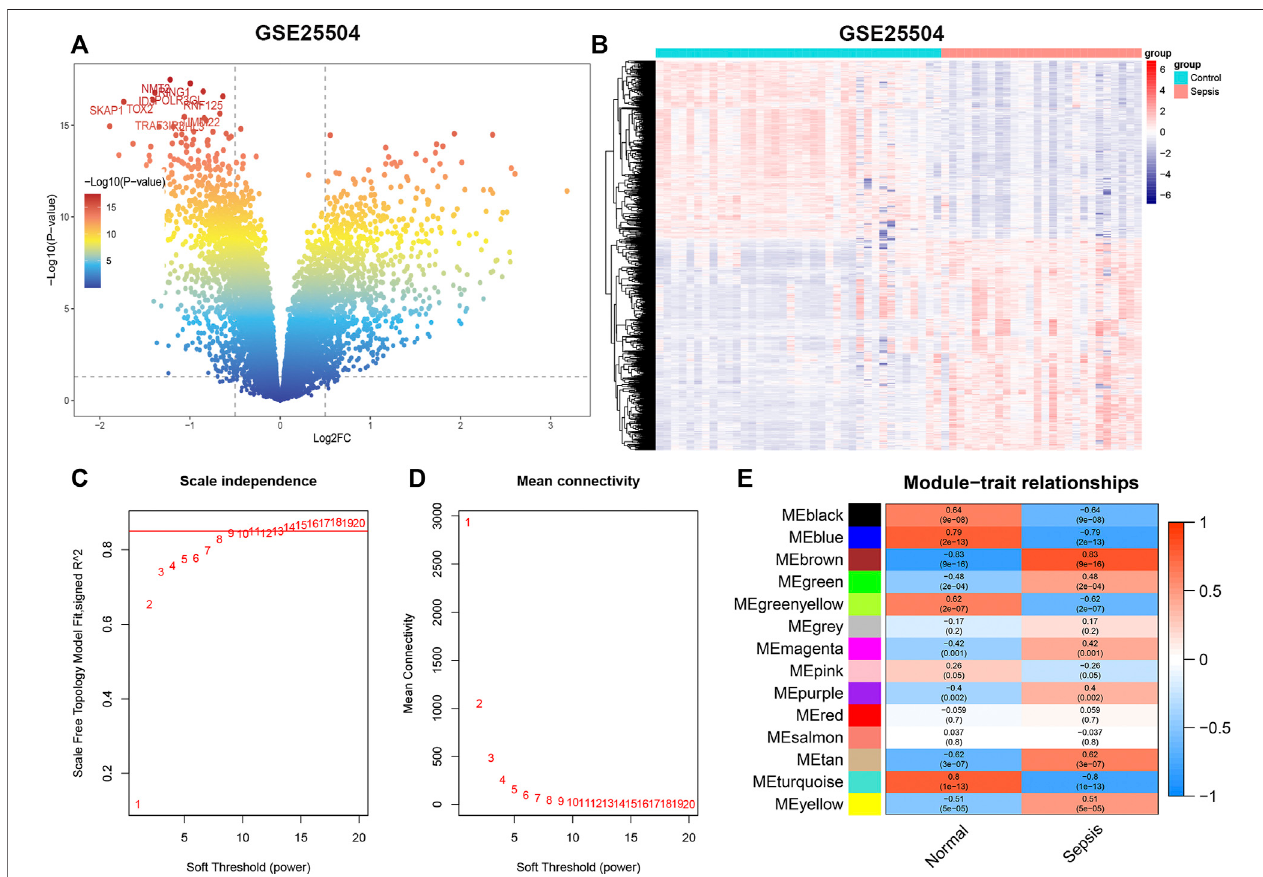
FIGURE3| GSE25504datasetsanalyzedbyDEGsandWGCNAmethods,respectively. (A) RepresentativevolcanoplotinGSE25504dataset. (B) Representative heat map of DEGs between normal subjects and sepsis patients. (C,D) Soft threshold selection process. (E) Correlation of modules with clinical characteristics. Each row represents a distinct module; each column represents a distinct clinical phenotype. Red rectangle indicates positive correlation; blue rectangle indicates negative correlation.